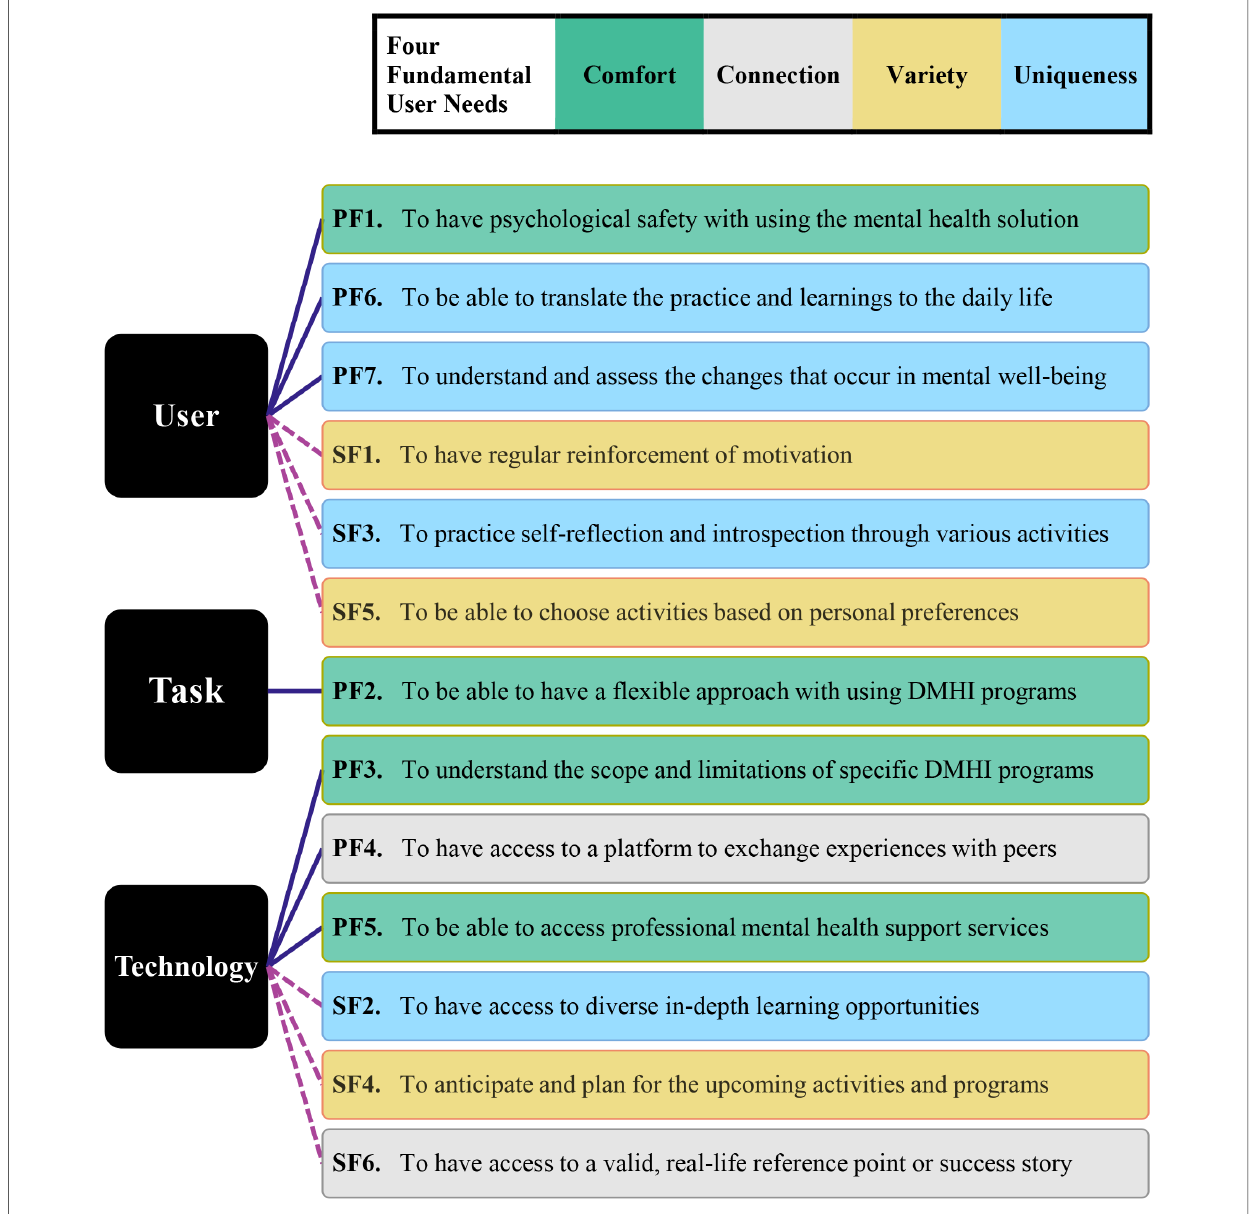
FIGURE 2 Integrative diagram to inform the user experience of universal school-based DMHIs. Note . The color scheme of each primary factor (PF#) and each secondary factor (SF#) corresponds to the color scheme representing the four fundamental user